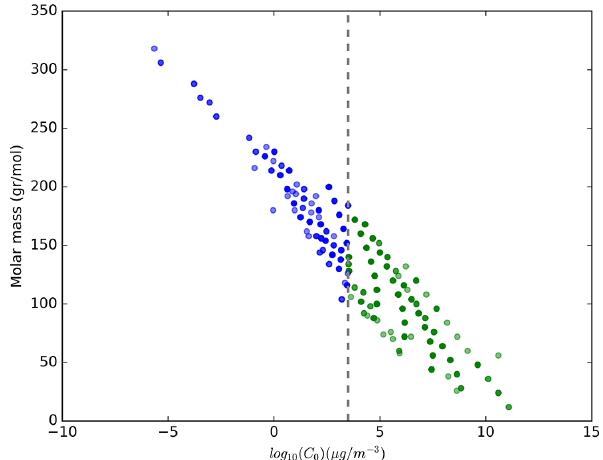
Figure 1. Saturation mass concentrations at 298K (Li et al., 2016) versus molar mass of organic tracers in EMAC. The blue dots repre- sent those included in ORACLE, i.e. organic tracers that are allowed to condense explicitly on aerosols under atmospheric conditions; the green dots represent those organic tracers that are always in the gas phase. The dashed line represents the maximum volatility con- sidered in ORACLE (i.e. 3 . 2 × 10 3 µgm − 3 ) for the VOC oxidation